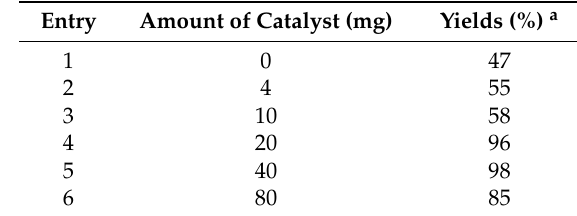
Table 3. Effect of different catalyst amounts of PW on product yields (%). Reaction conditions: 4-toluidine (1 mmol); acetonylacetone (1 mmol); PW catalyst; solvent-free; temperature, 60 ◦ C; time, 45 min; stirring.